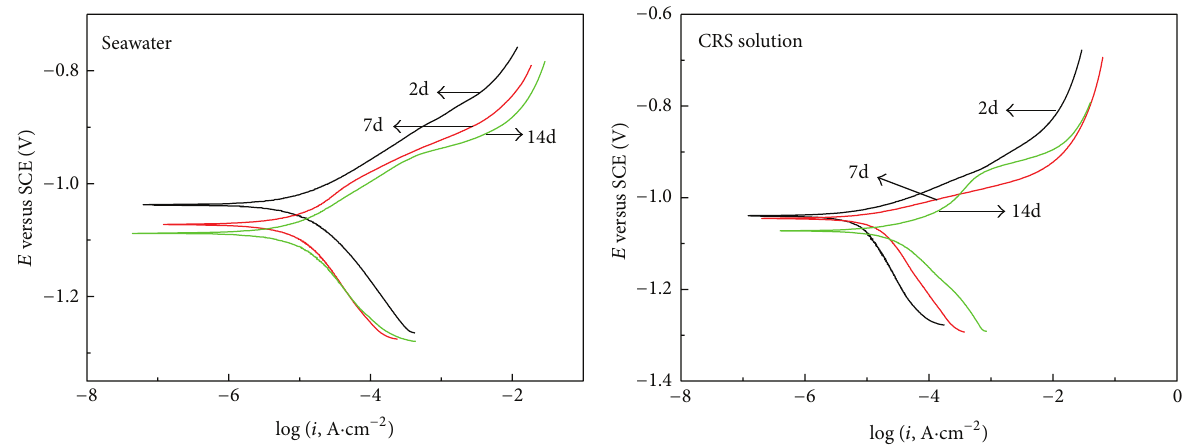
Figure 4: Tafel polarization curves of galvanized steel immersed at 0.1MPa hydrostatic pressure and 293K in seawater and CRS solution after different immersion times.